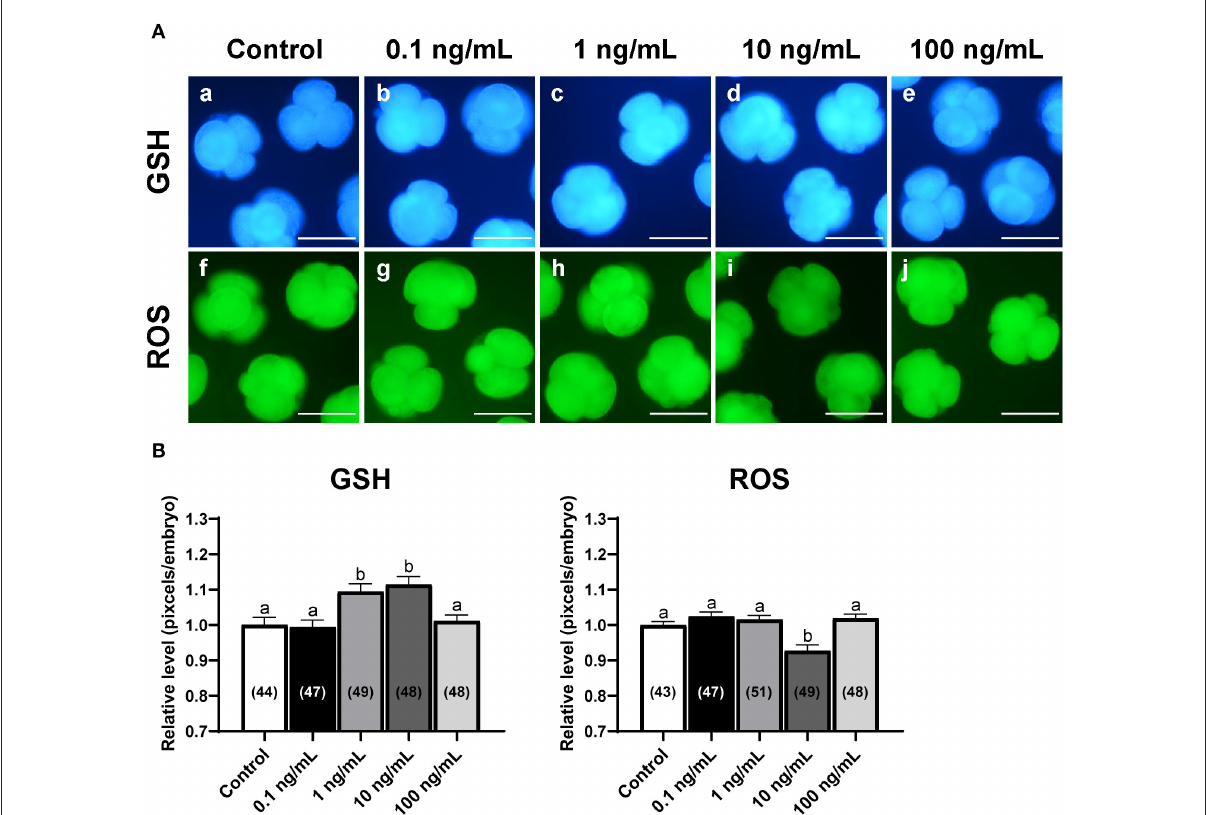
FIGURE3 Epifluorescence photomicrographs of PA-derived 4-cell embryos with various concentrations of IL-7 supplementation during IVC for 2 days. (A) Embryos were stained with Cell Tracker Blue (a–e) and H 2 DCFDA (f–j) to detect intracellular levels of glutathione (GSH) and reactive oxygen species (ROS), respectively. Scale bar: 100 µ m. (B) The relative levels of intracellular GSH and ROS levels within in vitro cultured porcine embryos treated with IL-7 during IVC. The number of embryos examined in each experimental group is shown in parentheses. Within each endpoint, bars with different letters (a,b) are significantly different ( p < 0.05) for each group. For all graphs, the values represent the mean ± SEM. The experiment was replicated four